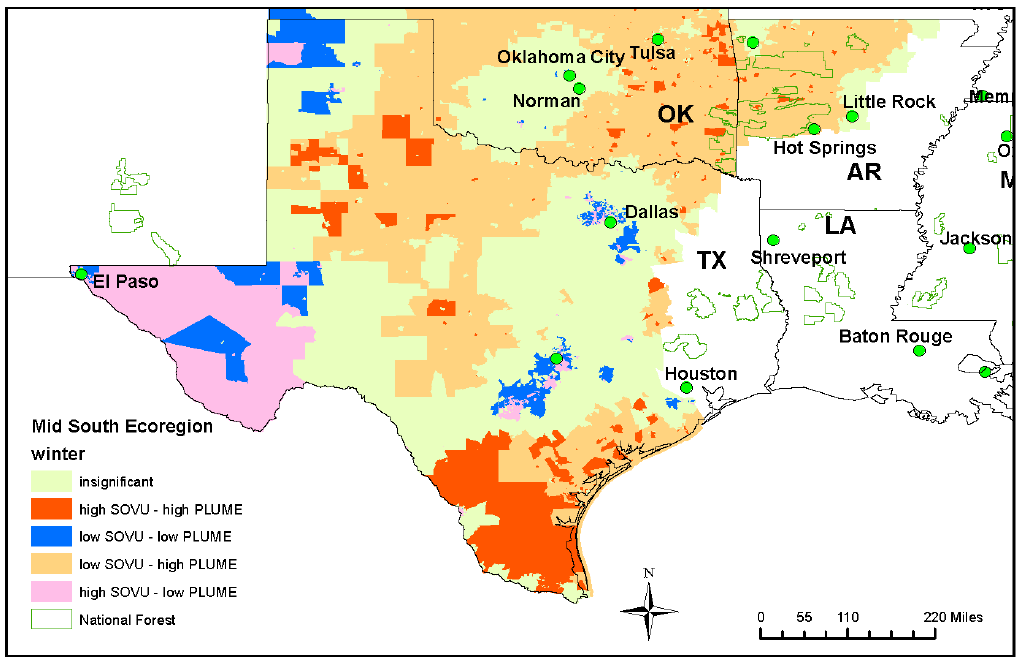
Figure 12. Bivariate LISA mapping of social vulnerability and smoke plume in the Mid-South ecoregion—winter.